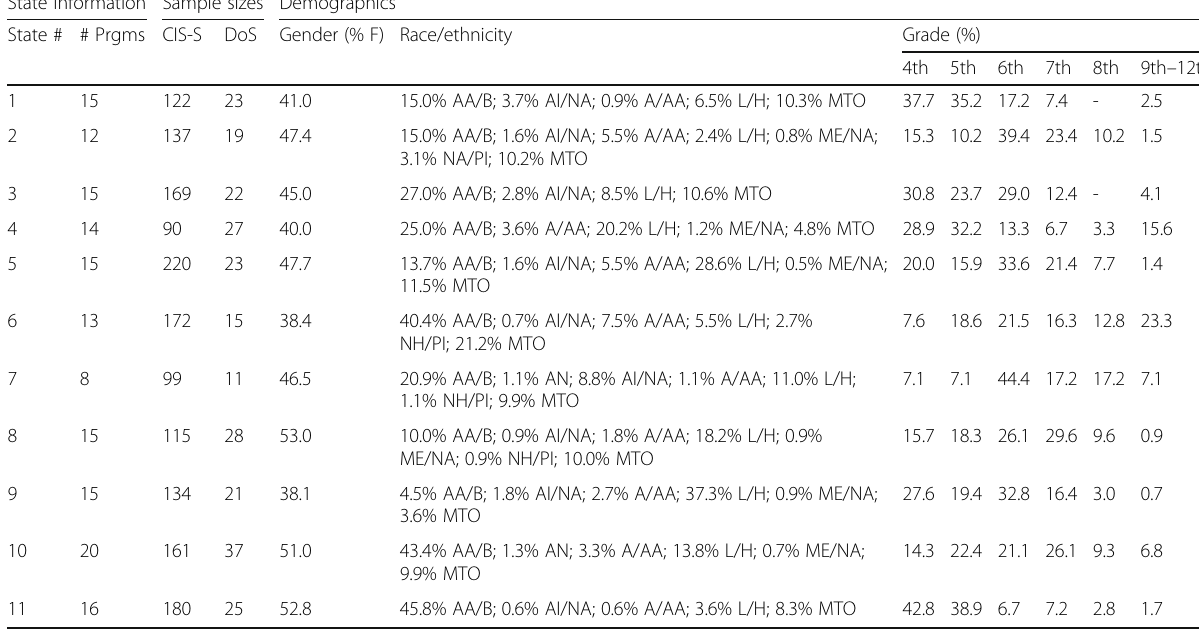
Table 1 Student demographics and sample sizes within the 11 state networks State information Sample sizes